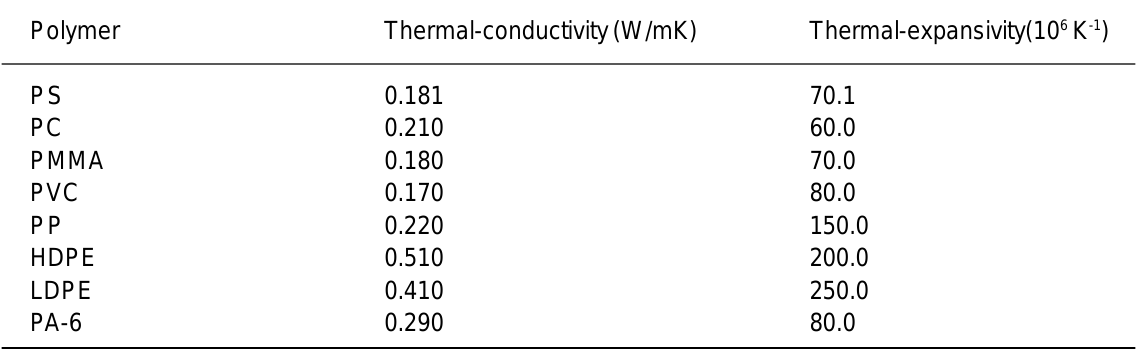
Table 3. Thermal expansivity/conductivity of